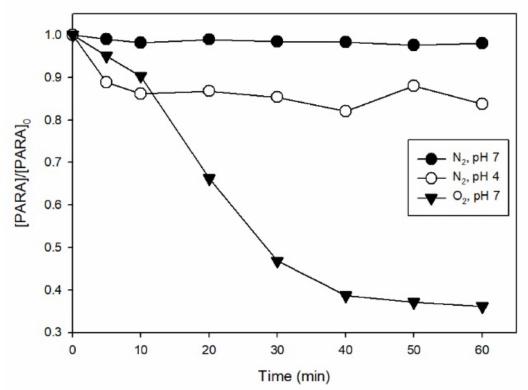
Figure 5. Effect of oxygen on PARA degradation with UVA irradiation. Conditions: [PARA] 0 = 10 µ M, [Fe(III)] 0 = 0.1 mM, [S(IV)] 0 = 1.0 mM (the PARA degradation at pH 4.0 with O 2 is depicted in Figure 3B).